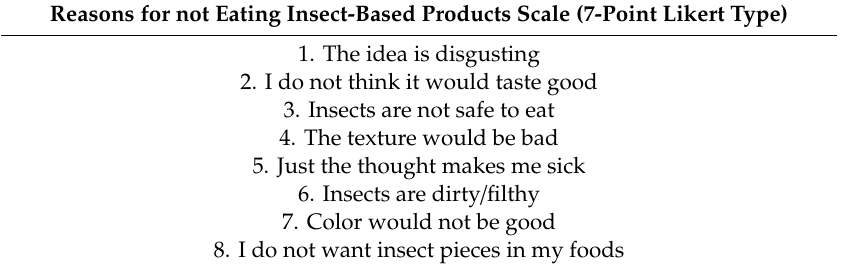
Table 1. The reasons for not eating foods containing insect powder as an ingredient. Reasons for not Eating Insect-Based Products Scale (7-Point Likert Type) 1. The idea is disgusting